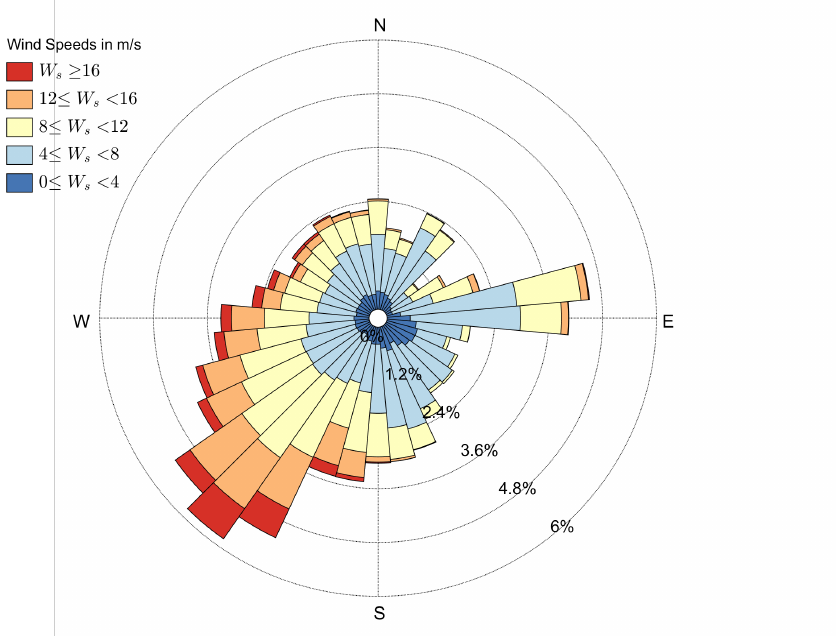
Figure 2. Wind rose from the IJmuiden weather station maintained by the Royal Netherlands Meteorological Institute KNMI (2011–2016). The station is located approximately 15 km to the south of the field site. A relatively large portion of easterly winds falls within the 80 and 90 ◦ bins. This is possibly caused by local tunneling of wind through the east-west oriented Noordzeekanaal (located to the east of the wind station). At other weather stations along the Dutch coast easterly winds are more spread out over all easterly